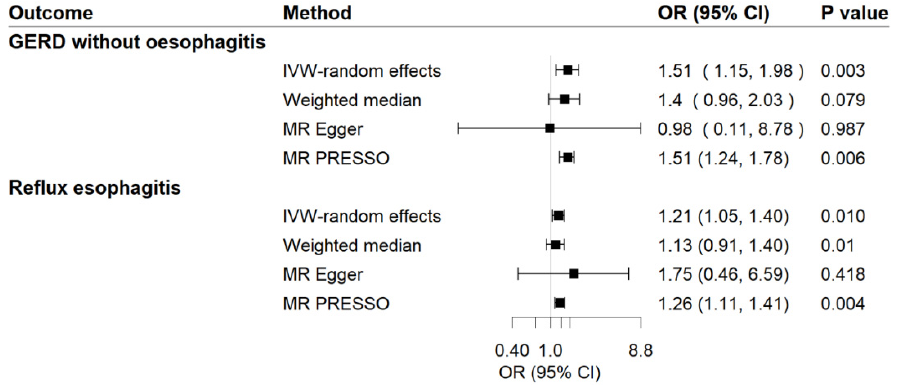
Figure 2. Associations of MDD with risk of GERD in MR analyses. The ORs of GERD were scaled to a 1-unit increase in log OR of MDD. IVW, inverse variance weighted; OR, odds ratio; CI, confidence interval; MR, Mendelian randomization.